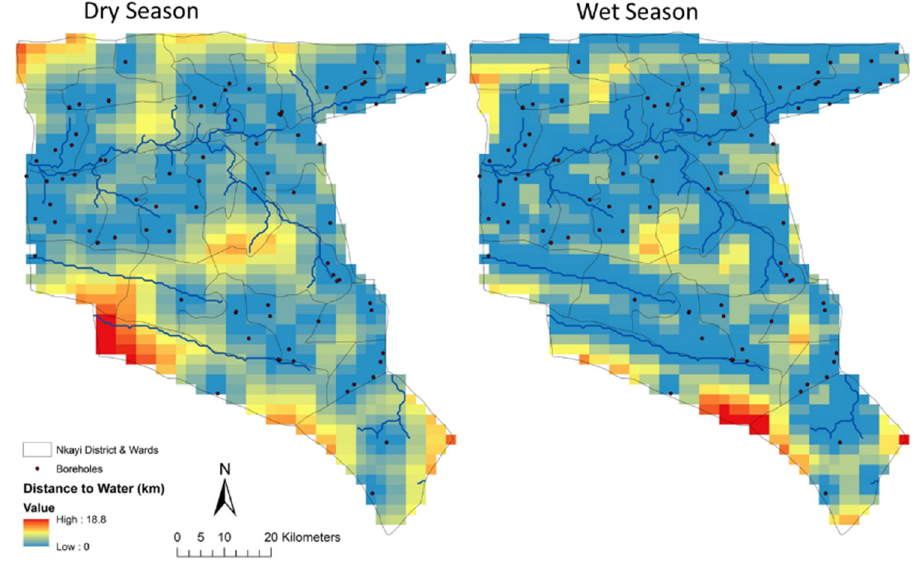
Figure 6. Distance to water (km) maps used as inputs to the SAVANNA model. The wet season grid was used in simulations from November to April while the dry season grid was used from May through October.